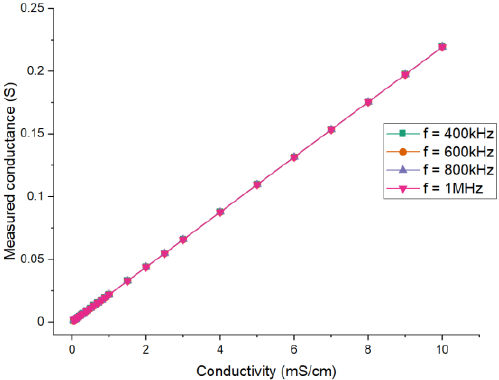
Figure 8. Simulation results for different excitation frequencies: the relationship between the measured conductance and the conductivity.